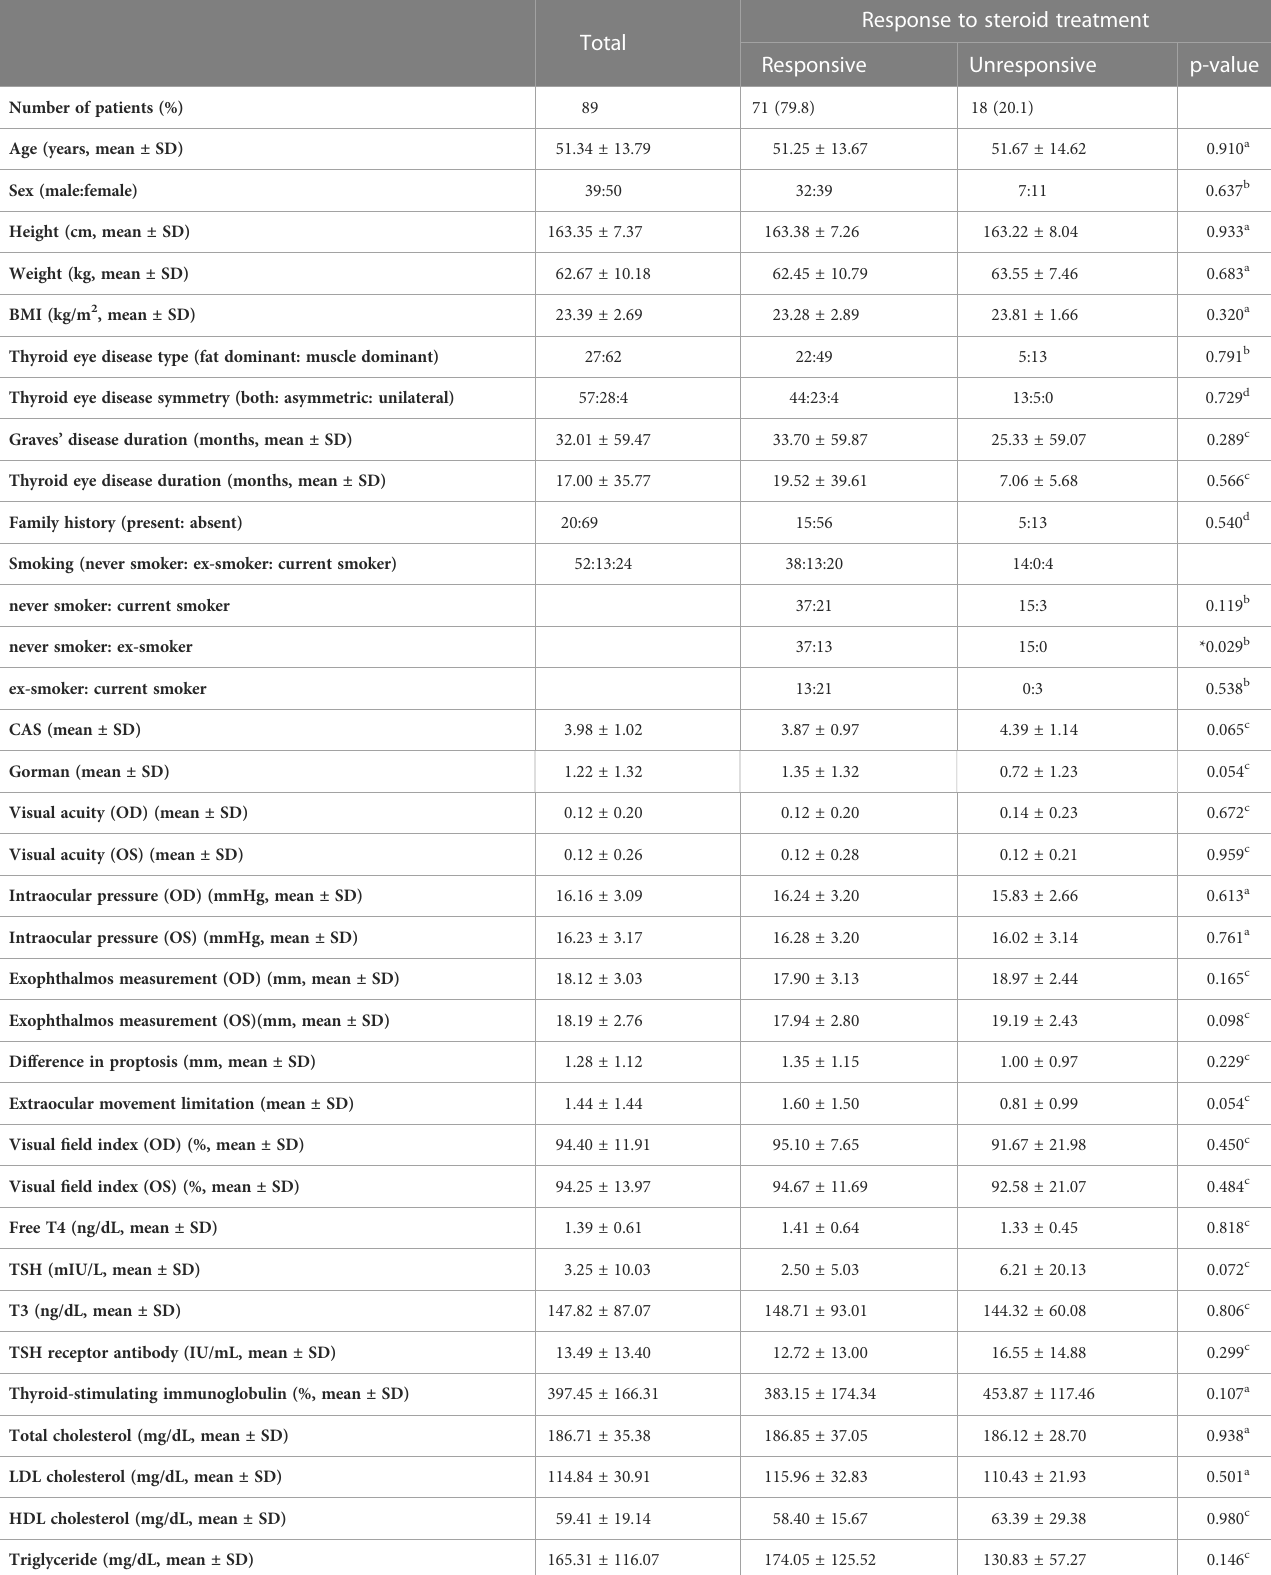
TABLE 1 Demographic characteristics of the responsive and unresponsive group.